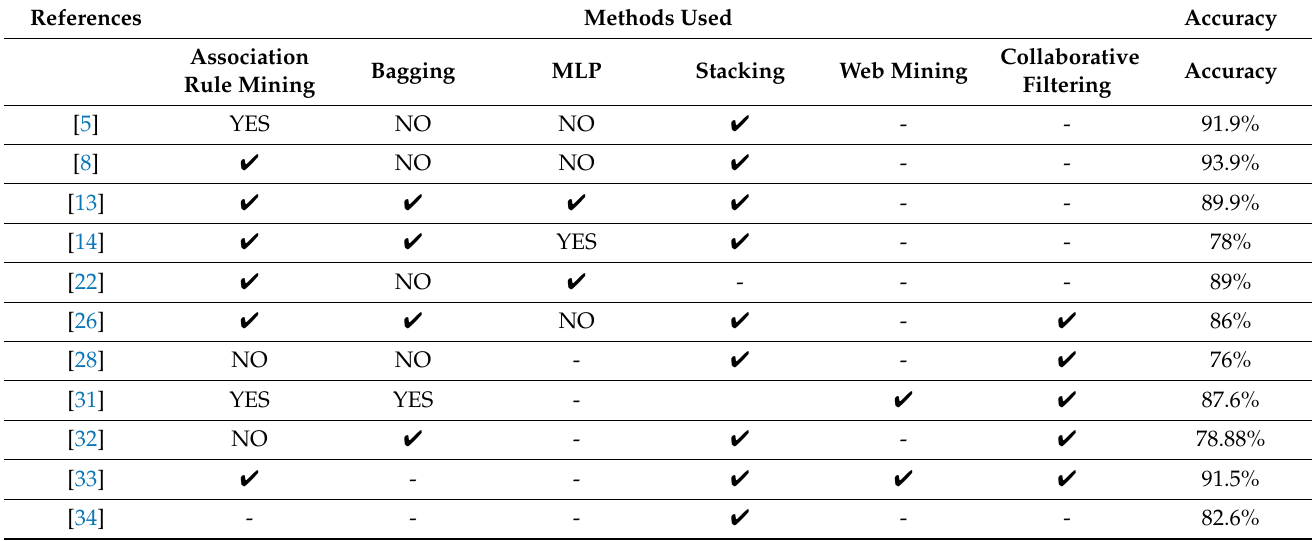
Table 1. Performance evaluation of state-of-the-art